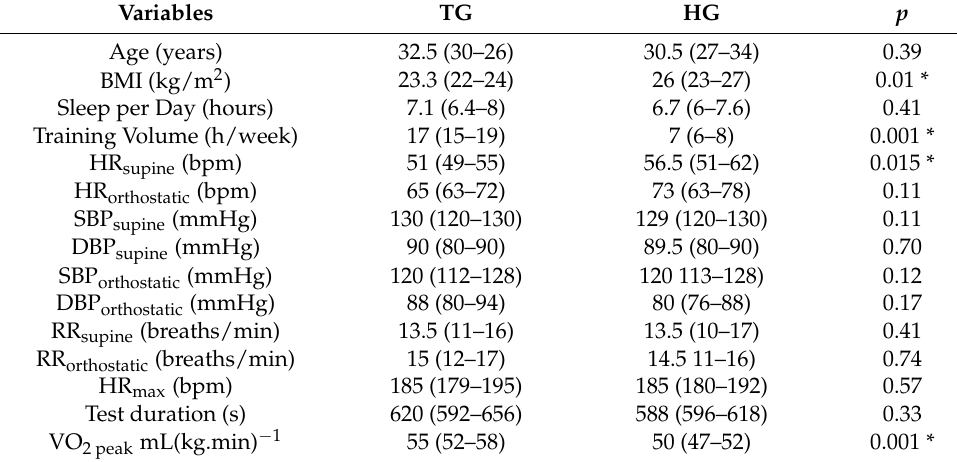
Table 1. Median (25th, 75th percentiles) of anthropometrical and basic physiological variables in the triathlon group (TG) and high-intensity interval training combined with different types of exercises group